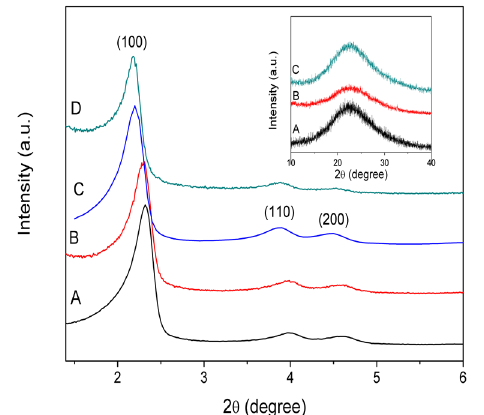
Figure 3. Small-angle powder XRD data of A) AzoMCM, B) Iri@AzoMCM, C) AlMCM-41 and D) Iri@AlMCM.